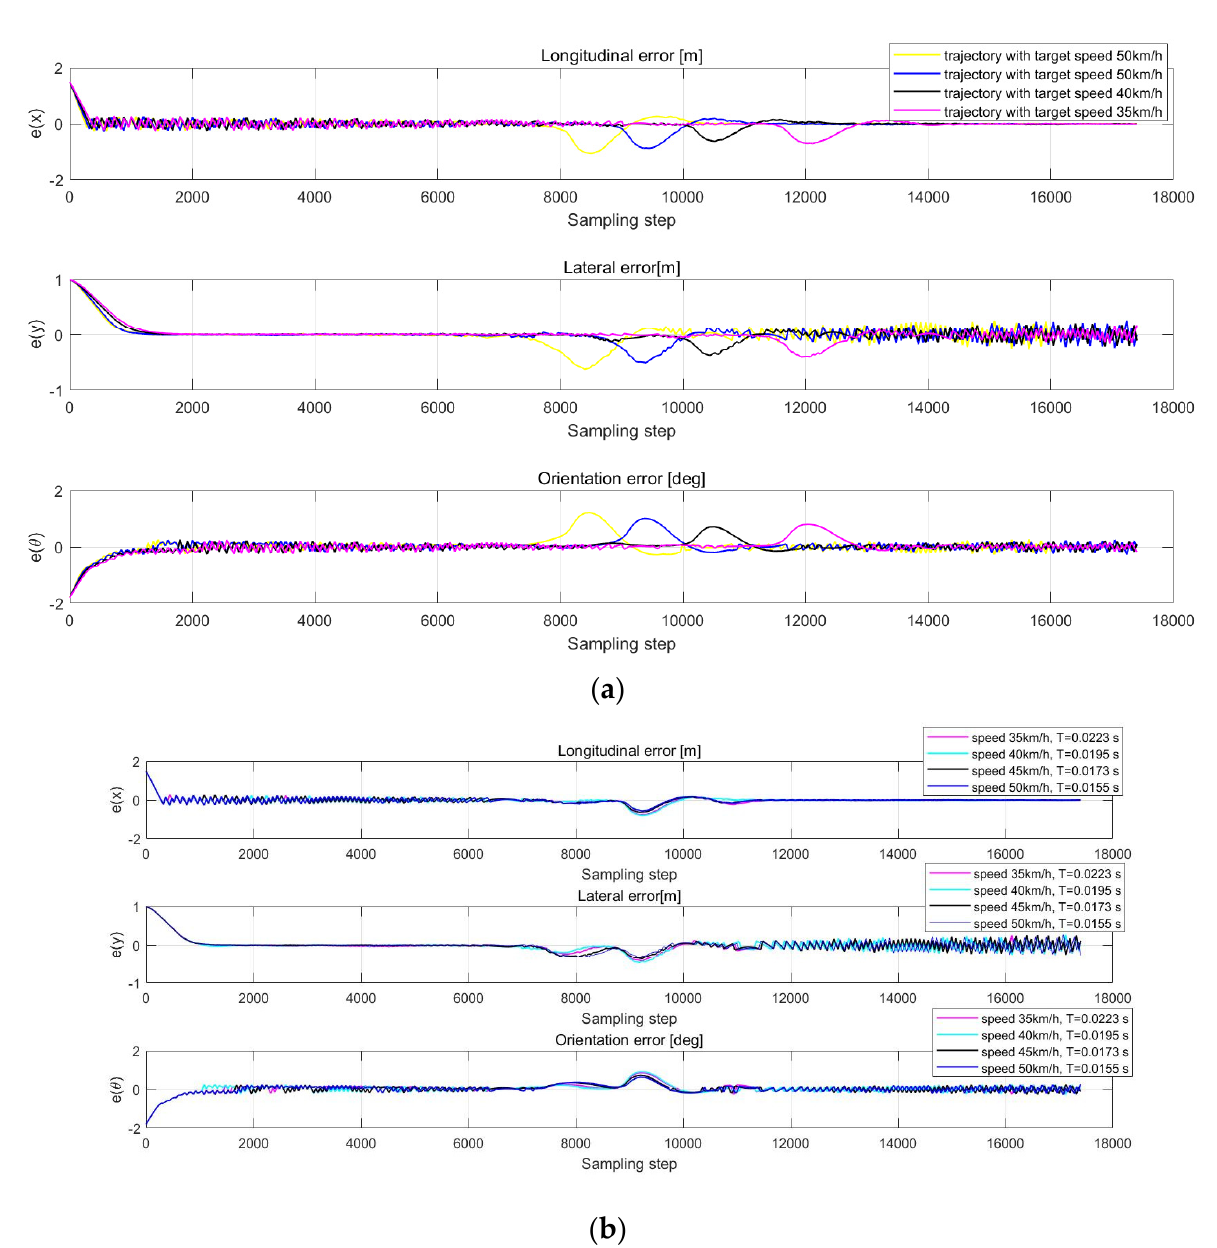
Figure 9. ( a ) Shows the comparison of trajectory errors after changing the target speed. ( b ) Compares trajectory errors after changing the target speed and the sample time T tuning condition. Figure 10a,b are the vehicle tracking heading performance and the longitudinal velocity. The yaw rate changes rapidly when passing through the curve area.